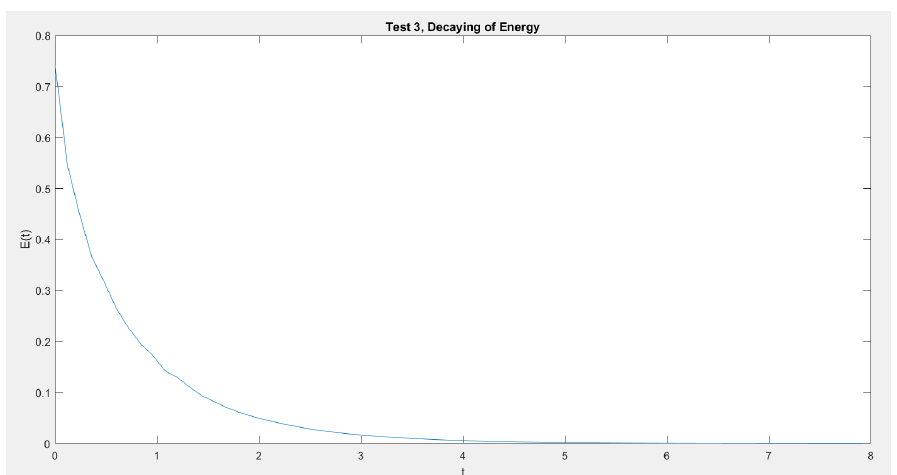
Figure 6. Test2: The energy decay.